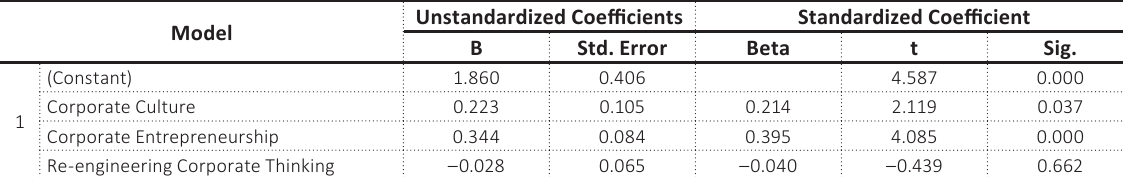
Table 11. Regressing intrapreneurship sub- variables on the process of production